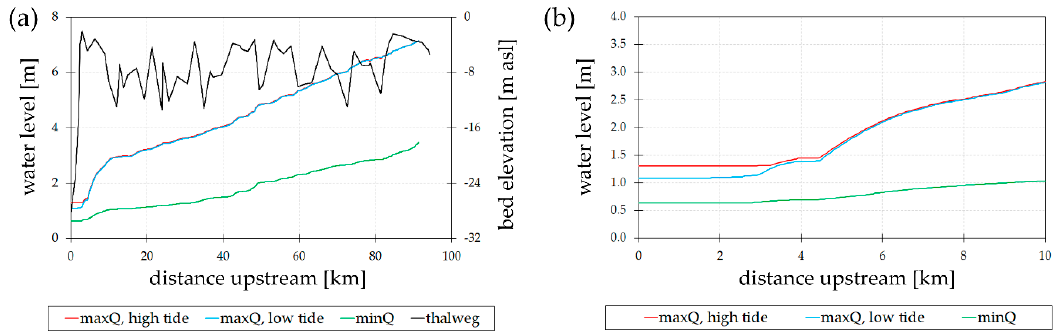
Figure 4. Simulated water levels along the Po River, with respect to the position of the core samples (0 km): (a) water profiles for maximum discharges ( Q = 8000 m 3 /s) at high tide (red line) and low tide (blue line), and for low flow conditions ( Q = 1000 m 3 /s, green line). The thalweg is indicated with the black line, while the ground elevation is reported on the secondary y -axis; (b) zoom of the last 10 km, focusing on the water levels.